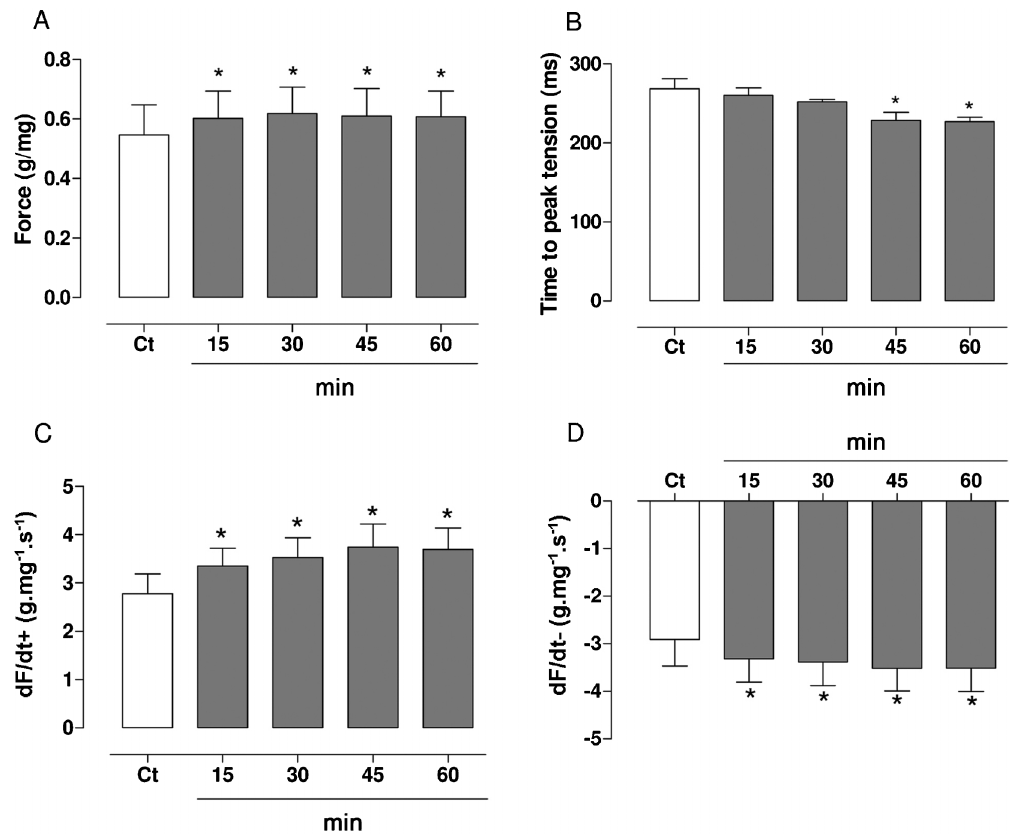
Figure 1. Effects of 8 m M lead acetate on the time course changes of isometric force ( A ), time to peak tension ( B ), dF/dt + ( C ) and dF/dt- ( D ) of rat left ventricular papillary muscles. Results are reported as means ± SE for 5 animals. Ct = control; dF/dt = time derivatives of left ventricular force development. *P , 0.05 for lead vs Ct (one-way repeated measures ANOVA followed by the Tukey test).